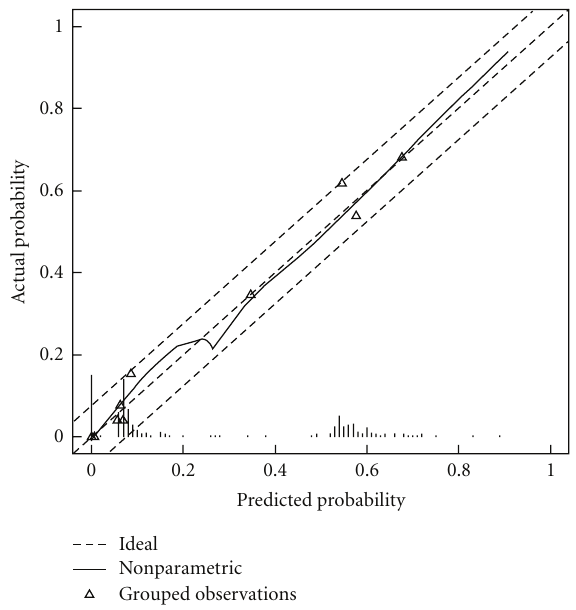
Figure 2: Calibration plot for external validation cohort. The x - axis shows the prediction calculated using the nomogram, and the y -axis gives observed rates of significant Gleason sum upgrading for patients in the validation cohort. Dashed line indicates reference line, where an ideal nomogram would lie. Solid line indicates performance of the nomogram applied to the validation cohort. The solid line is close to the dashed line of the ideal nomogram and is always within the 7.5% margin of